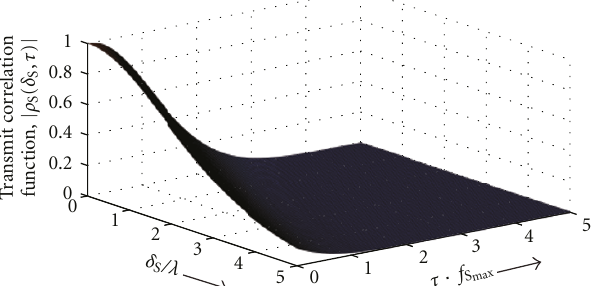
Figure 12: Absolute value of the relay CF | ρ R ( δ R , τ ) | of the 2 × = 60 ◦ and κ = 2 × 2 MIMO M2M reference channel model under nonisotropic S S scattering conditions (von Mises density with φ (0) and κ S-R = κ R-D =